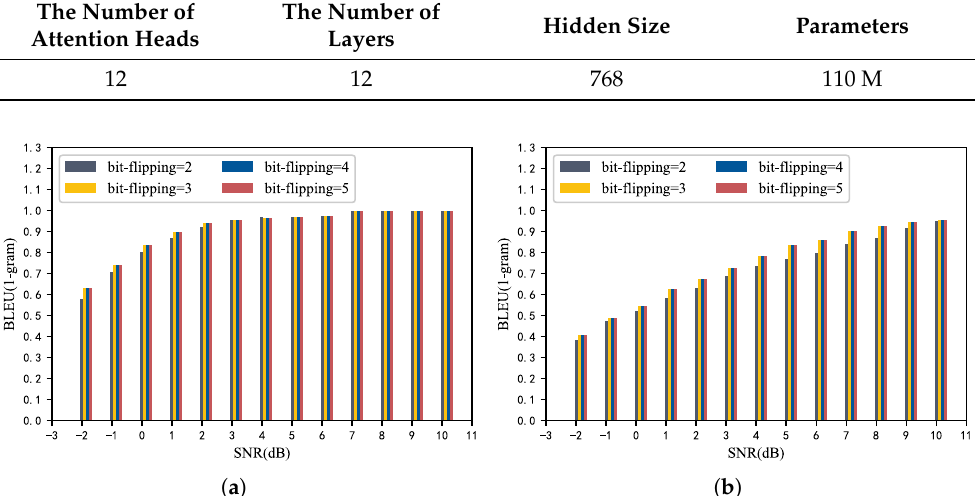
Figure 2. BLEU(1-g) scores under different numbers of bit-flips versus SNR over the AWGN channel and the Rayleigh fading channel. ( a ) AWGN channel. ( b ) Rayleigh